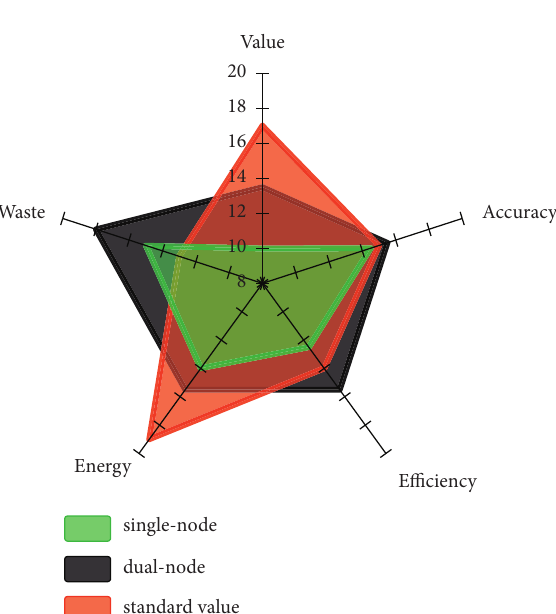
Figure 8: Memcached single-node versus dual-node processing